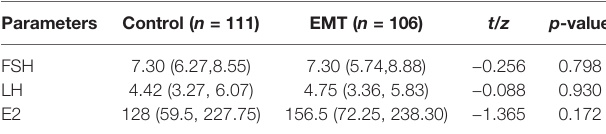
TABLE 2 | Frequencies of the ApoE genotype and frequencies in the control group and patients with